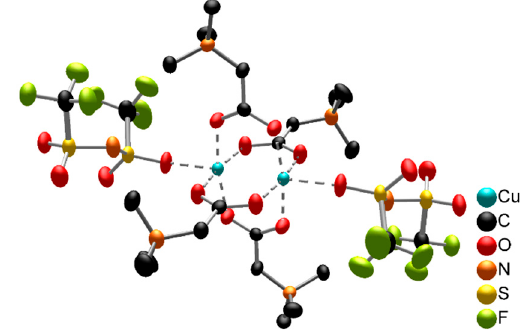
Figure 5. The water-free metal-betaine complex [Cu 2 (bet) 4 (NTf 2 ) 2 ] 2+ obtained by the dissolution of CuO in [Hbet][NTf 2 ]. Coordinative interactions are marked as dotted lines. The ellipsoids enclose 70% of the probability density of the atoms at 100 K. H atoms are omitted for clarity.